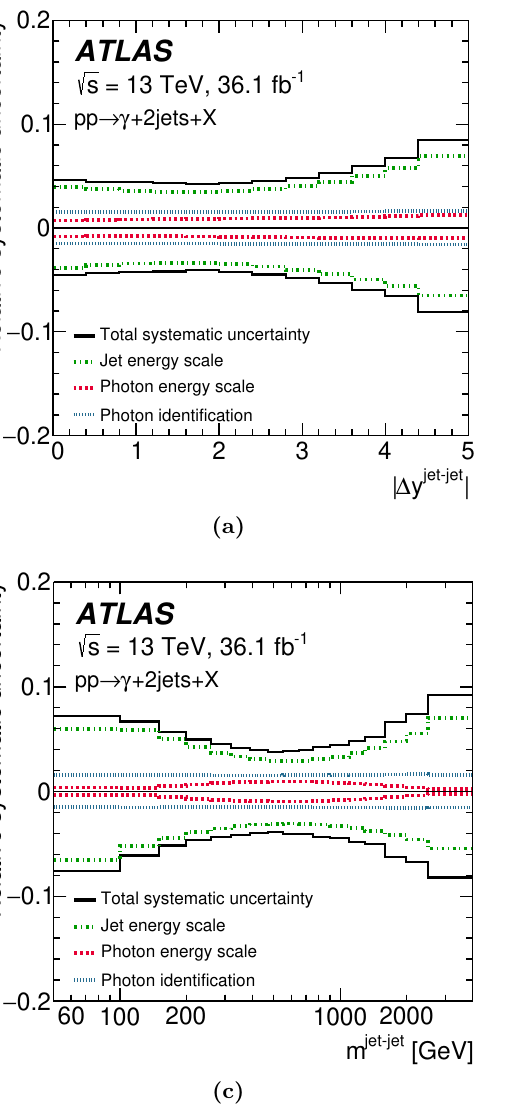
Figure 3 . Total relative systematic uncertainty in the measured cross-sections (black lines), exclud- ing the uncertainty of the luminosity determination, together with the three main contributions, namely jet energy scale (dot-dashed lines), photon energy scale (dashed lines) and photon identi(cid:12)- cation (dotted lines), as a function of (a) j (cid:1) y jet{jet j , (b) (cid:1) (cid:30) jet{jet , (c) m jet{jet and (d) m (cid:13) {jet{jet for the total phase